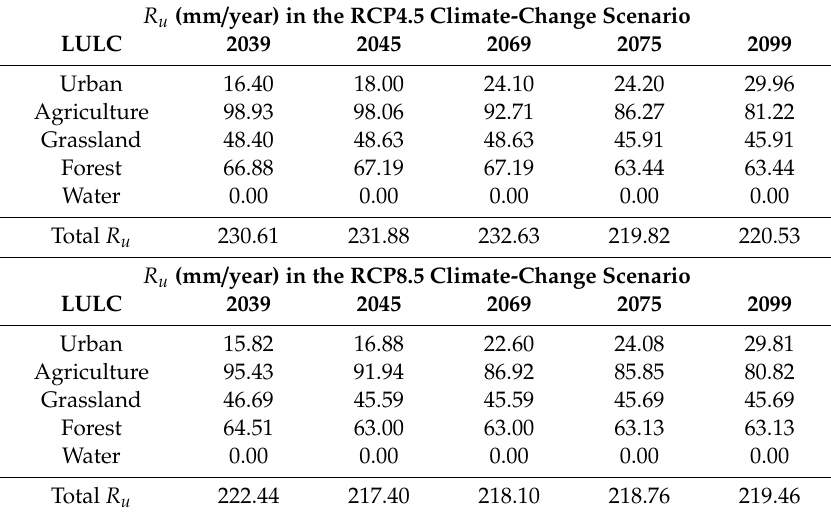
Table 9. R u values for the climate-change scenarios by